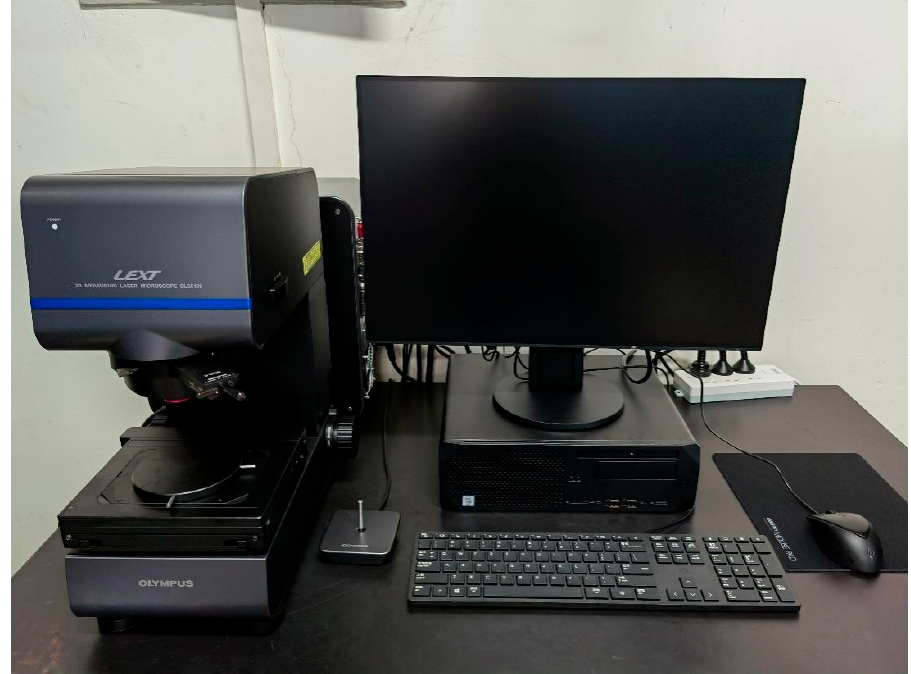
Figure 4. Three-dimensional Measuring Laser